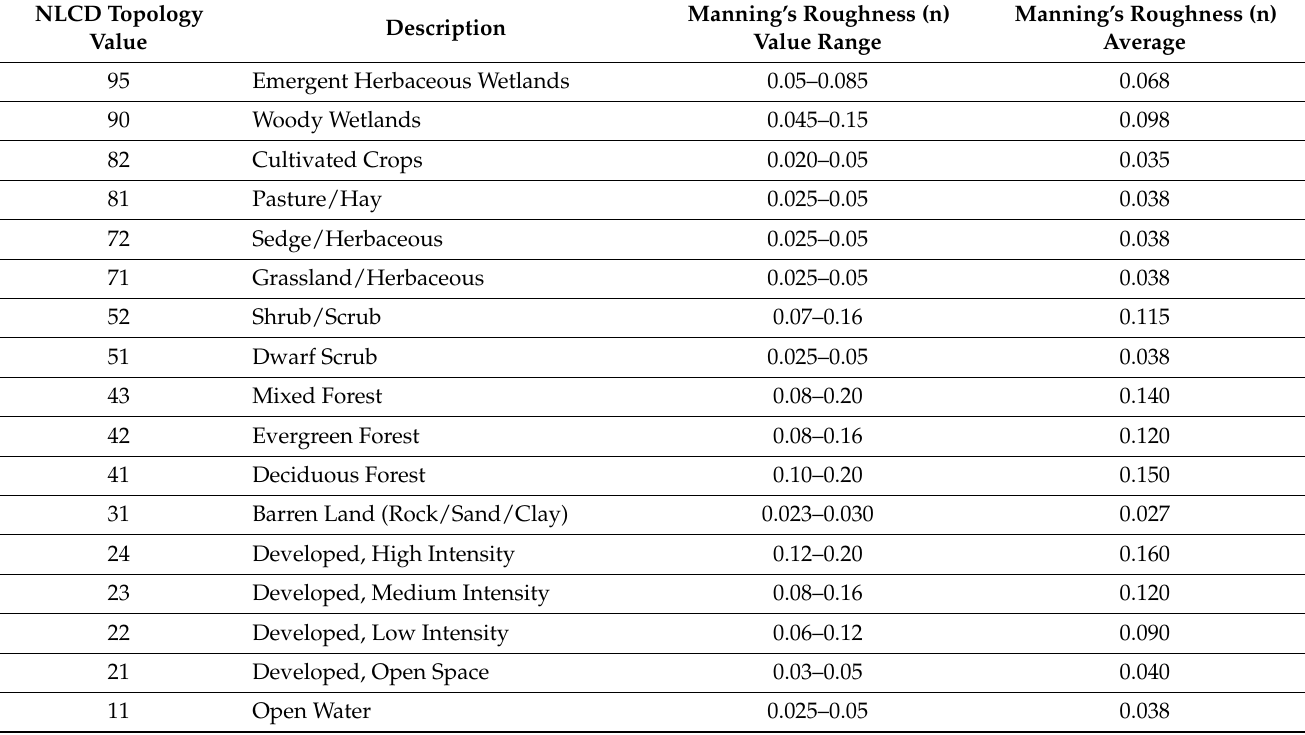
Table 3. NLCD-Manning’s n Values Reference Table based on Chow-1959